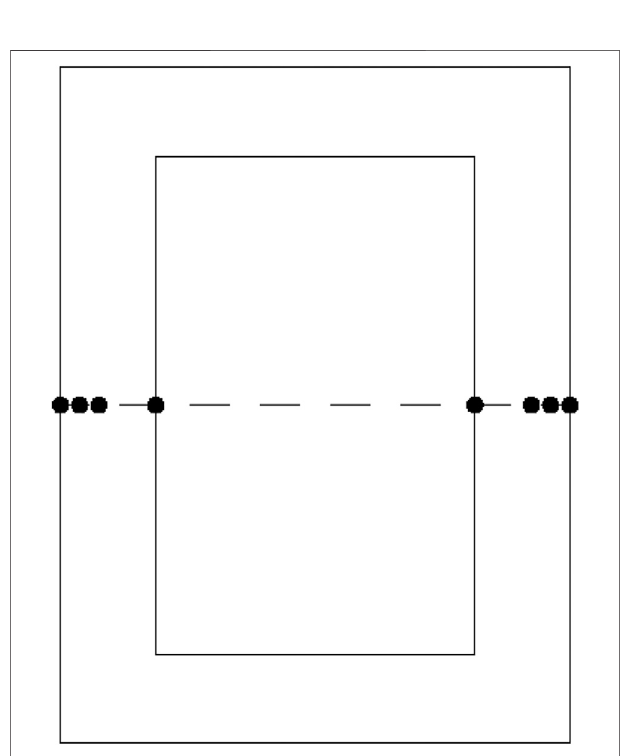
FIGURE 6 | The measuring points at the midline of the cross-section at the height of 144.8 m.